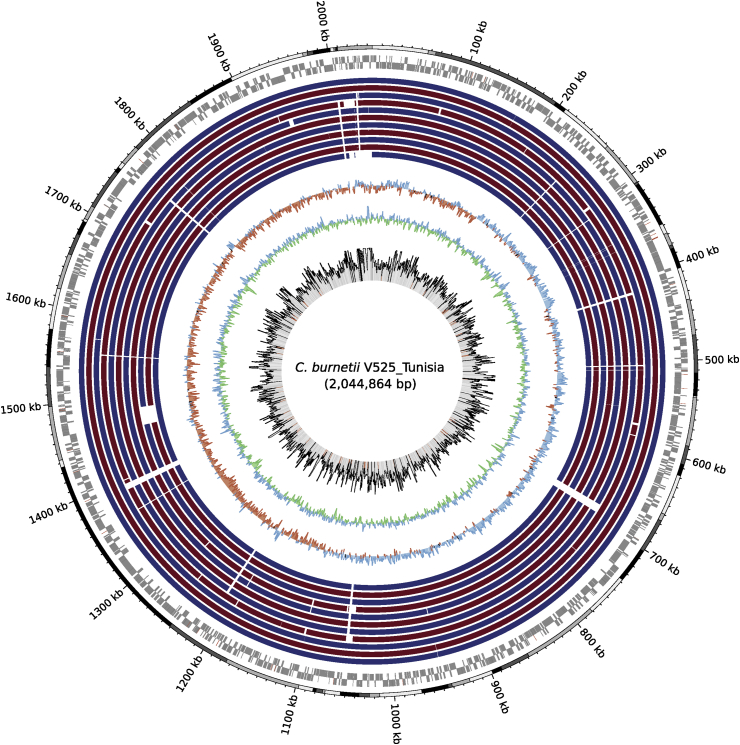
Circular map of 2 044 864 bp assembly. First black and grey outer circle indicates contig boundaries of Coxiella draft genome. Contigs were ordered on basis of genome of strain CbuK_Q154. Next two circles report open reading frames of leading and lagging strands. Eleven inner circles report sequence conservation with 11 complete Coxiella genomes. From outside to inside: (1) C. burnetii CbuK_Q154; (2) C. burnetii MSU Goat Q177; (3) C. burnetii Dugway 5J108-111; (4) C. burnetii CbuG_Q212; (5) C. burnetii Cb175_Guyana; (6) C. burnetii RSA 493; (y) C. burnetii RSA 331; (8, 9, 10) C. burnetii strain 3262 (two genomes); (11) C. burnetii Z3055. All strains exhibited >99% of average nucleotide identity with reference (Supplementary Table S3). Following two inner circles report GC skew (red for negative, blue for positive) and GC content (blue for above average, green for below average) of reference genome. Innermost circle reports variations in sequencing depth (median depth of 1546×); regions exhibiting sequencing depth of <800× are highlighted in red.